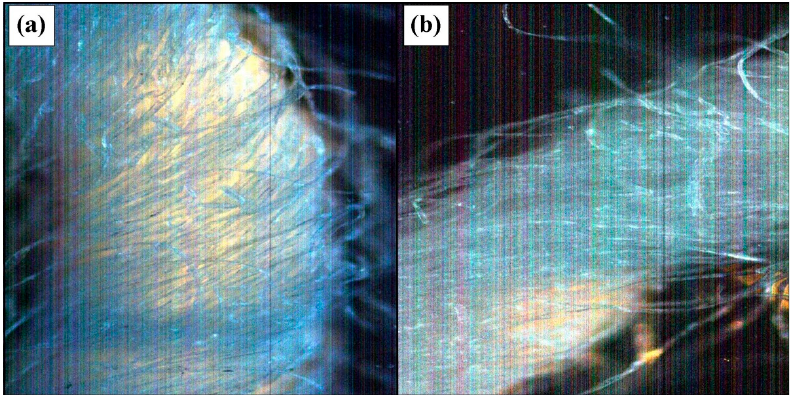
Figure 8. Dark-field image of a thread from the cotton fabric (( a ) before washing; ( b ) after lye washing) .